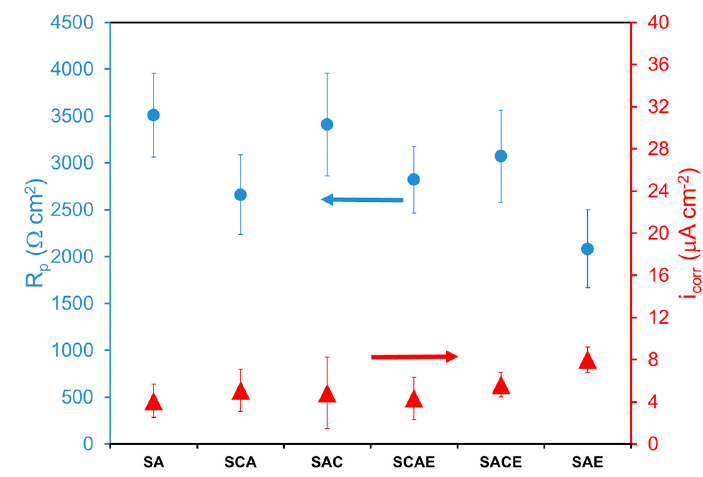
Figure 4. Polarization resistance ( R p ) and corrosion current density ( i corr ) of different AA6012 samples in aerated